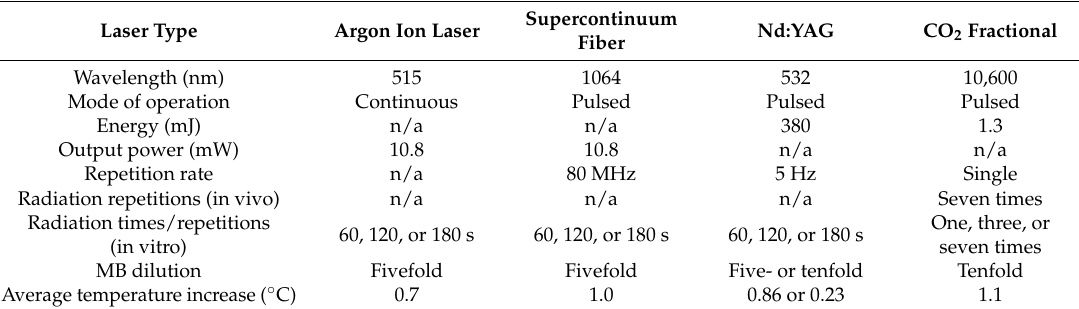
Table 1. Conditions and parameters of the argon-ion laser, supercontinuum fiber laser, Nd:YAG laser, and CO 2 fractional laser used when measuring laser-induced microbubble (MB) disruption.